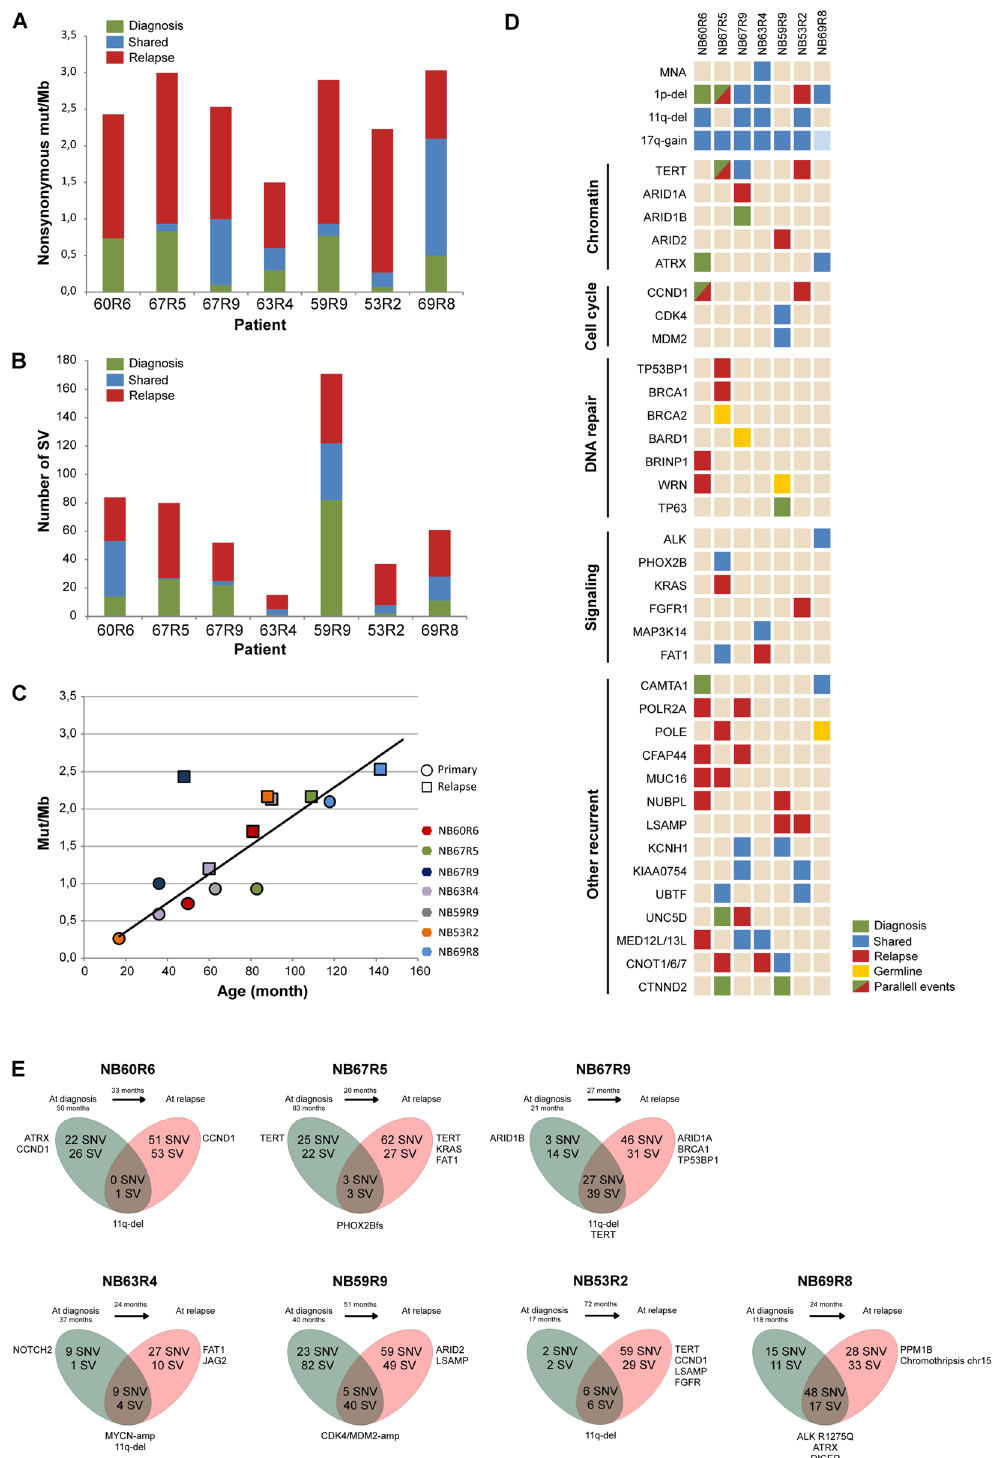
Figure 1. Mutational distribution of primary and relapsed NBs. ( A ) The number of non-silent somatic mutations per megabase identified in seven primary tumors and their corresponding relapse tumors. Mutations shared by primary and relapse tumors are shown in blue, mutations unique to primary tumors are shown in green, and mutations unique to relapse tumors are shown in red. ( B ) The total number of somatic structural variants identified in the seven primary tumors and their corresponding relapse tumors; color scheme as in ( A ). ( C ) Number of nonsynonymous somatic mutations per megabase in primary and relapse tumors in relation to age at time of diagnosis and age at time of relapse/progression. ( D ) Recurrent and other biological relevant copy number alterations and SNVs detected through WGS. ( E ) Case-by-case overview of somatic SNVs and SVs in primary and relapsed tumors with biologically relevant mutated genes and/or genomic alterations